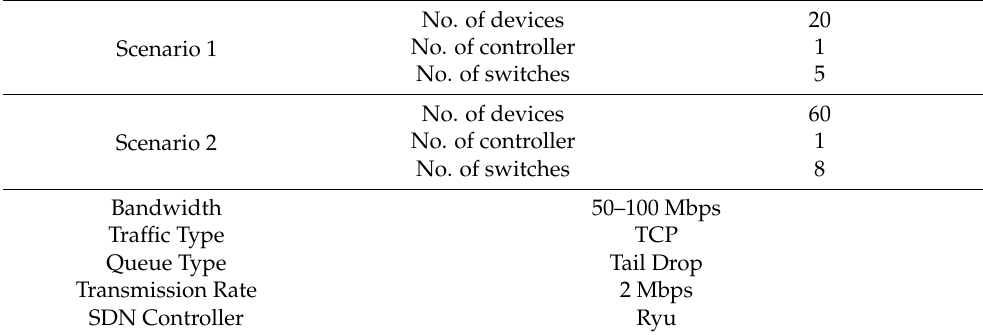
Table 1. Network